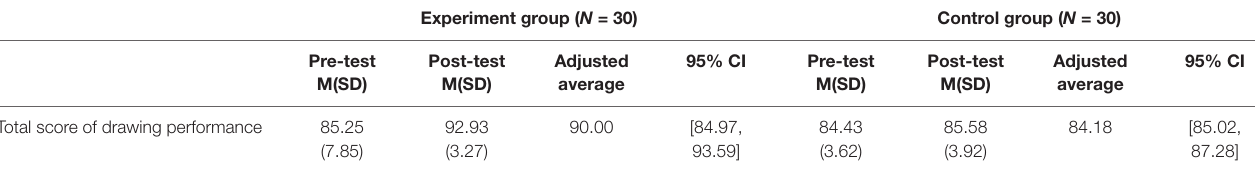
TABLE 3 | Summary of averages, standard deviations, and adjusted averages of both groups in “painting performance ability” in the pre-test and